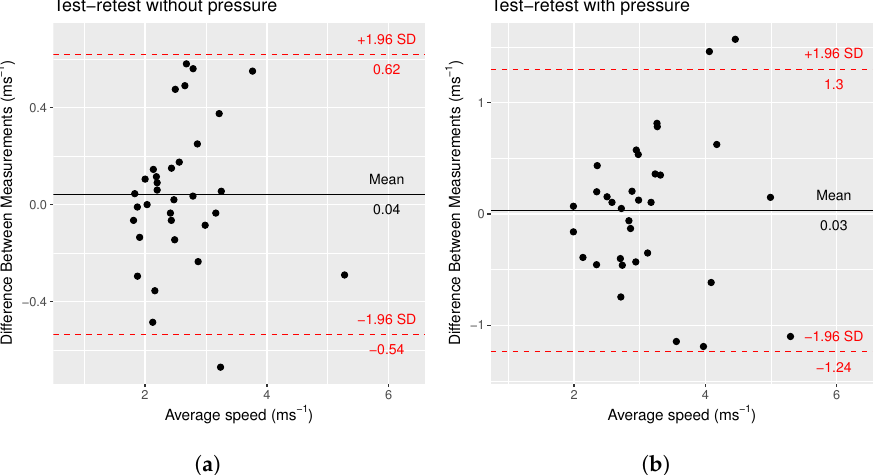
Figure 14. Bland–Altman plot of mean speed in the image for test–retest mean measured speed ( a ) without pressure and ( b ) with pressure. The 95% confidence intervals are marked in red. The increase in shear-wave speed is not uniform with the length cervix; it is concen- trated at the point of contact. The positioning of the discrete ROI bubbles is another factor that causes measurement errors. If pressure is applied at the internal os, the measured value at the internal os will increase while the value at the external os will remain the same. The change is concentrated such that small shifts in the ROI placement can lead to significant inconsistencies. In addition to problems with changes in shear-wave speed measures, the application of pressure also deforms the cervix. As a result, the ROI needs to be replaced for each elastogram. The difference in positions is an average of 1.47 mm horizontal 1.44 mm vertical for the internal ROI and an average of 1.23 mm horizontal 1.38 mm vertical for the external ROI. The shift in the ROI bubbles may be another source of error in the measurement